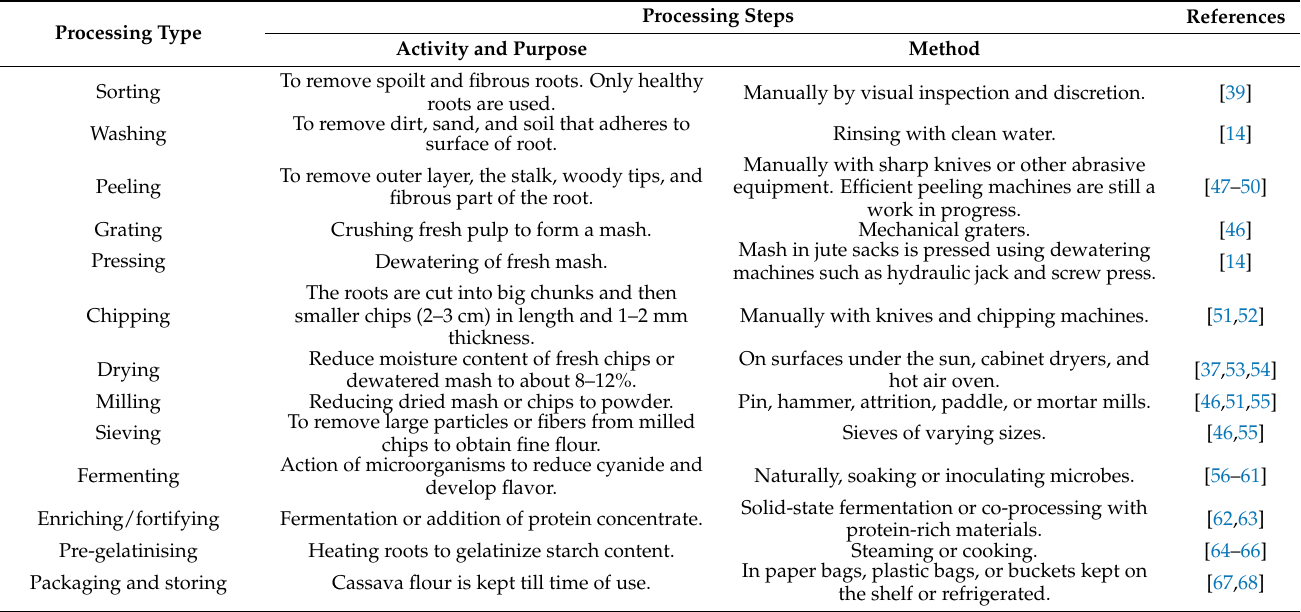
Table 1. Description of cassava flour processing